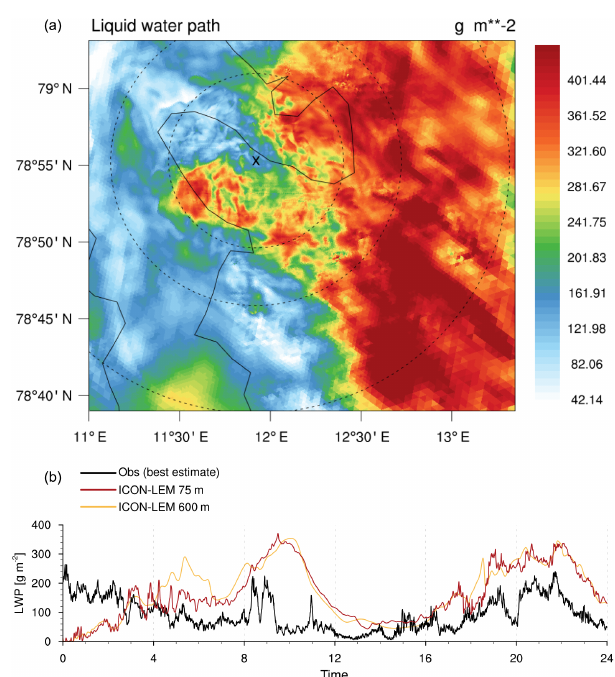
Figure 7. Snapshot of the LWP at 18:30 UTC on 15 June 2017 with an overlay of all four different resolutions, where the dashed lines indicate the size of the different domains, the solid line repre- sents the coast, and the x shows the location of Ny-Ålesund (a) . An LWP time series for the same day showing the best estimate of the observations and the coarsest (600m) as well as the finest (75m) ICON-LEM resolution (b)